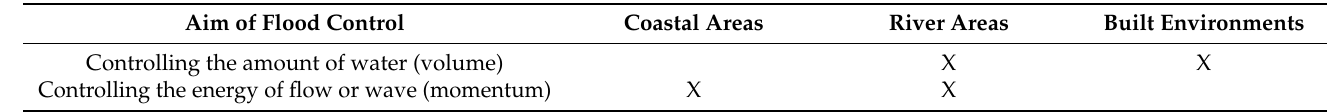
Table 3. General objectives of flood control in different areas. Aim of Flood Control Coastal Areas River Areas Built Environments Controlling the amount of water